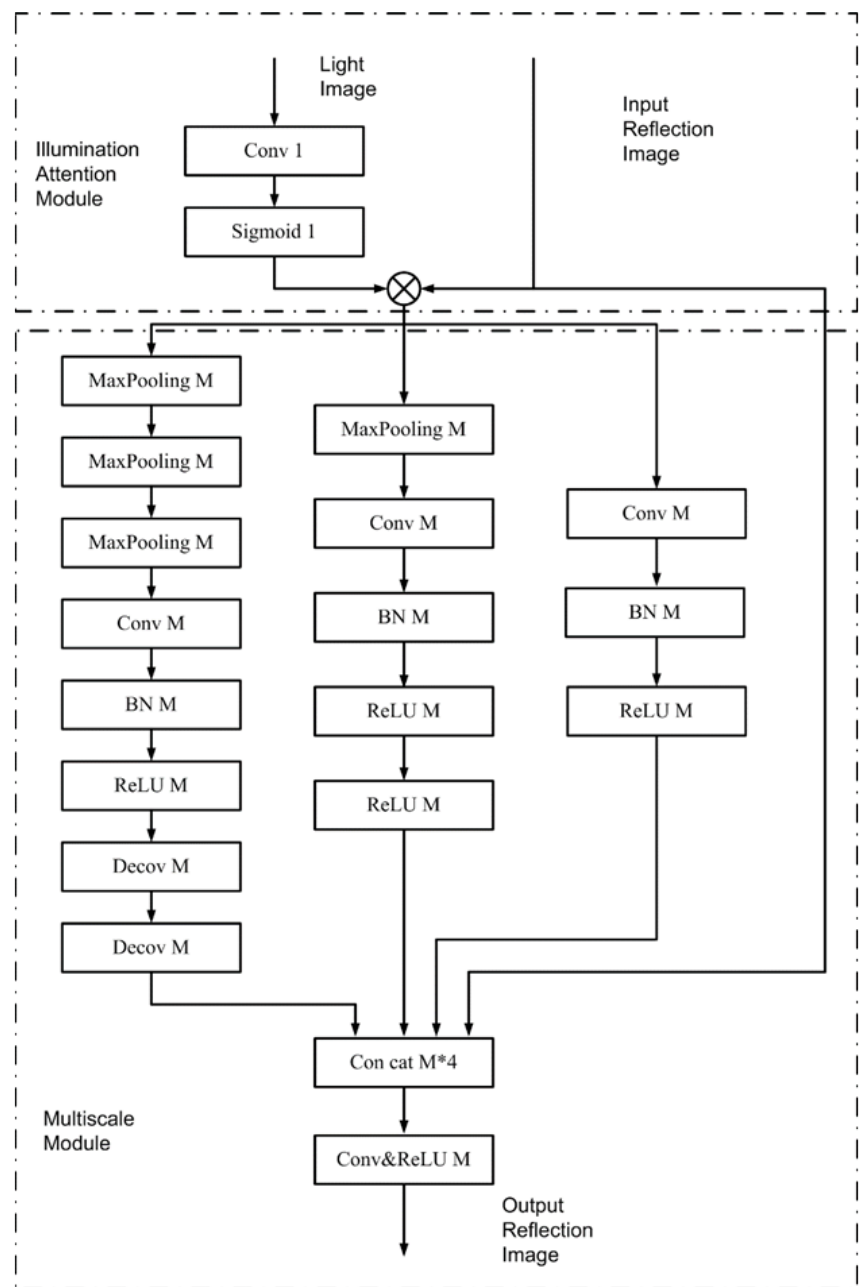
Figure 3. Multi-scale illumination attention